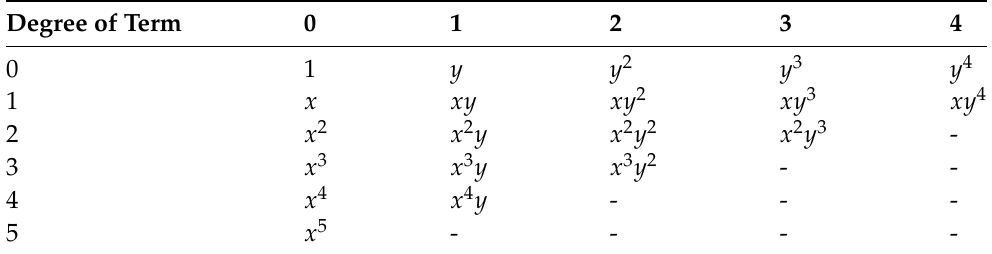
Table 4. Polynomial model